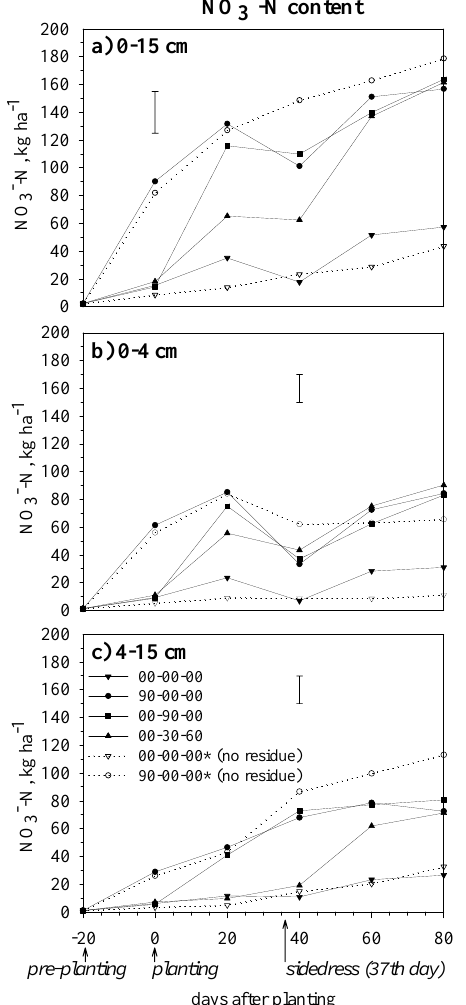
Figure 3. Soil NO 3- -N content in the 0–15 cm layer (a), 0–4 cm layer (b) and 4–15 cm layer (c)